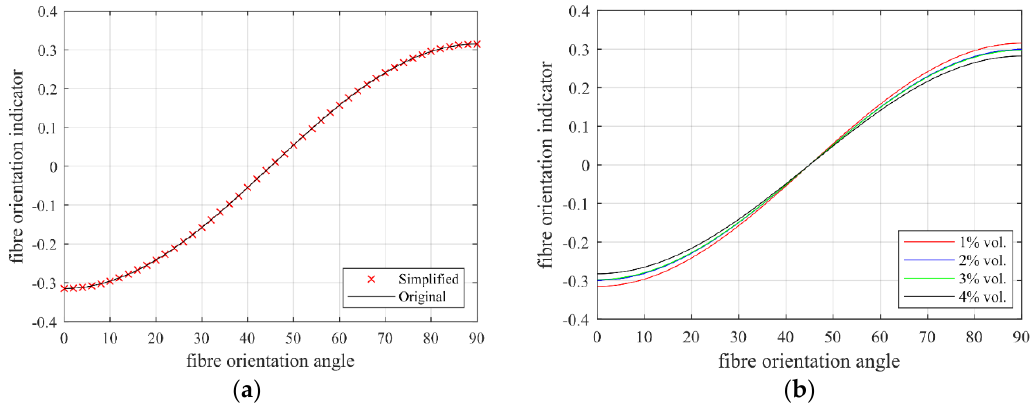
Figure 10. Relationship between fibre orientation angle (unit: degree) and fibre orientation indicator. ( a ) Comparison between simplified and original equation and ( b ) comparison between different fibre content.